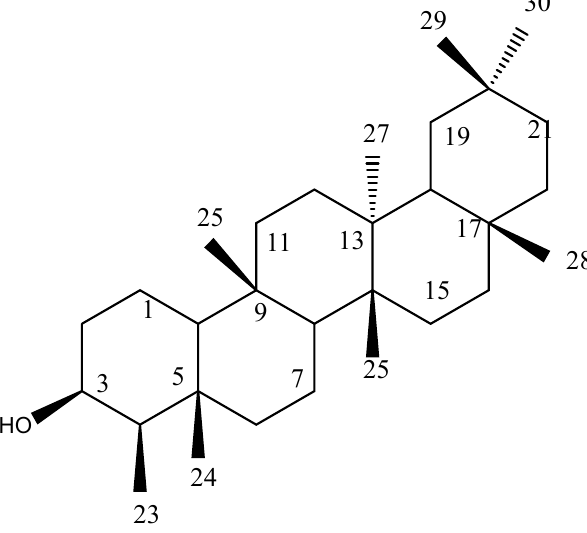
Figure 1. Chemical structure of EFD.